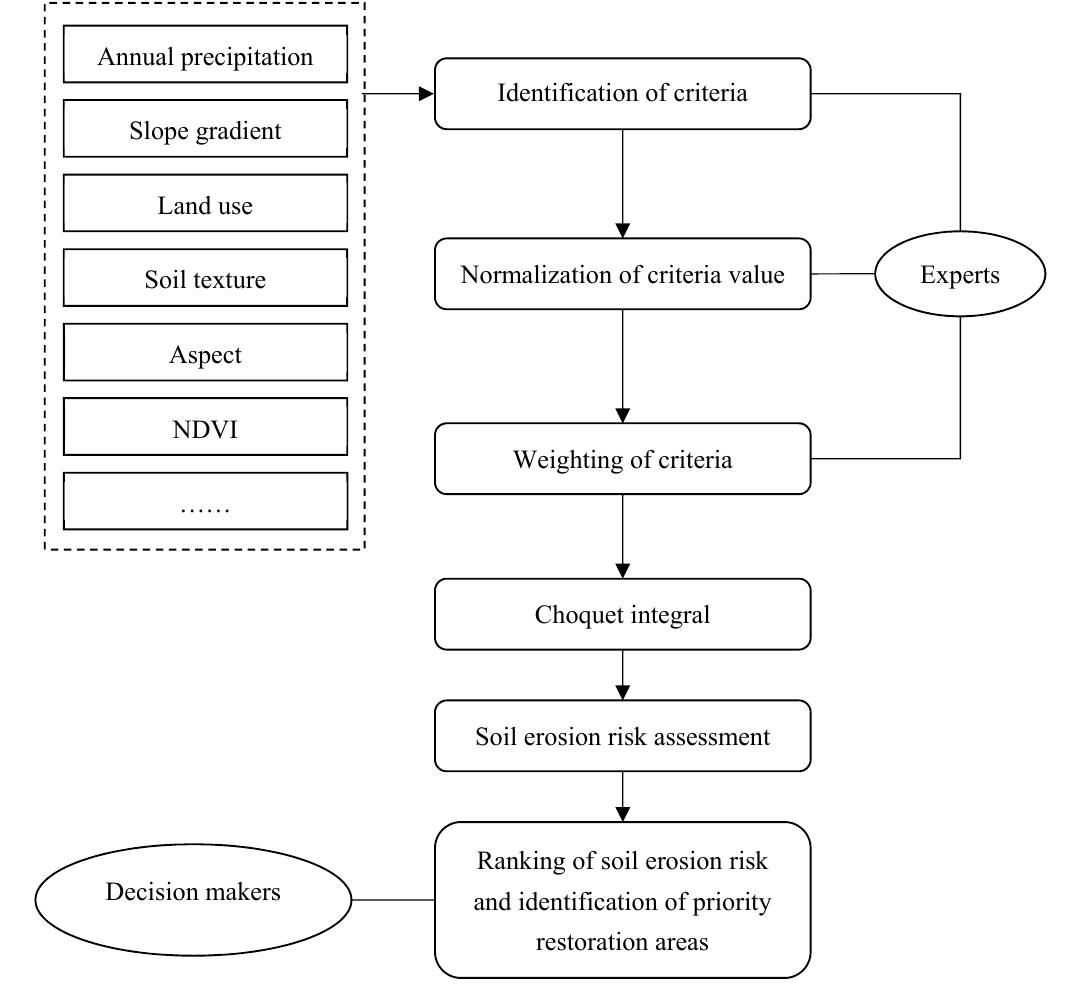
Figure 2. Framework for soil erosion risk